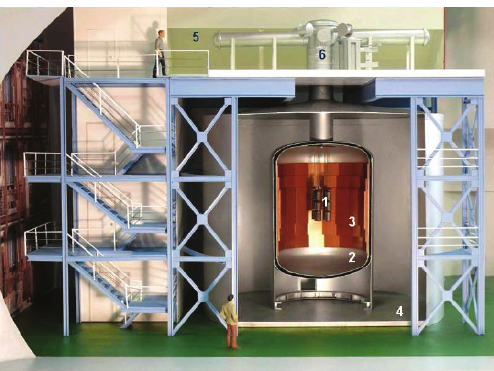
Figure 1: Artist view of the Gerda experiment. The following com- ponents are labeled in the picture: (1) the germanium array strings (not to scale), (2) the LAr cryostat, (3) the internal copper shield, (4) the instrumented water tank, and (5) the clean room with the lock insertion system (6). From